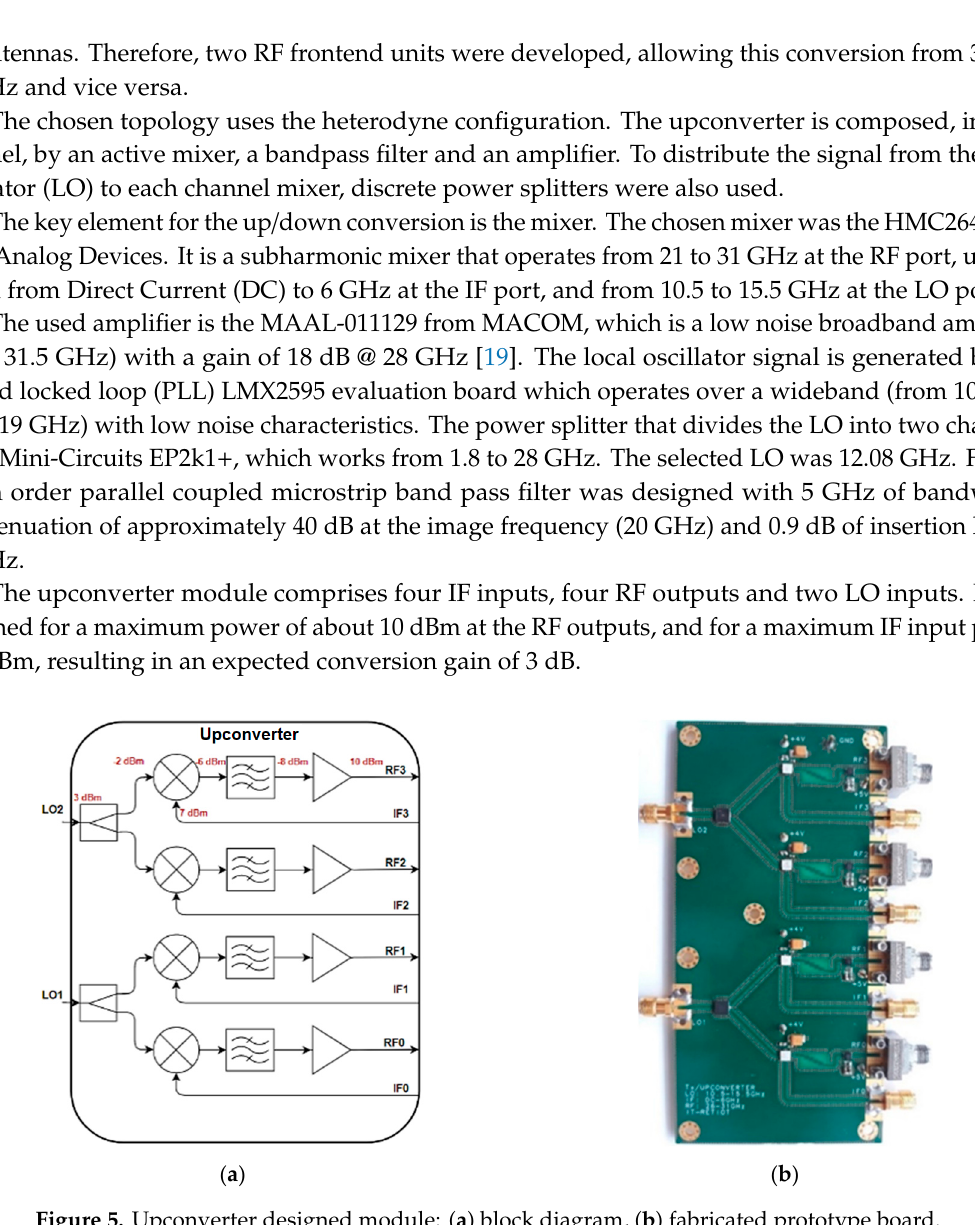
Figure 5. Upconverter designed module: ( a ) block diagram, ( b ) fabricated prototype board.